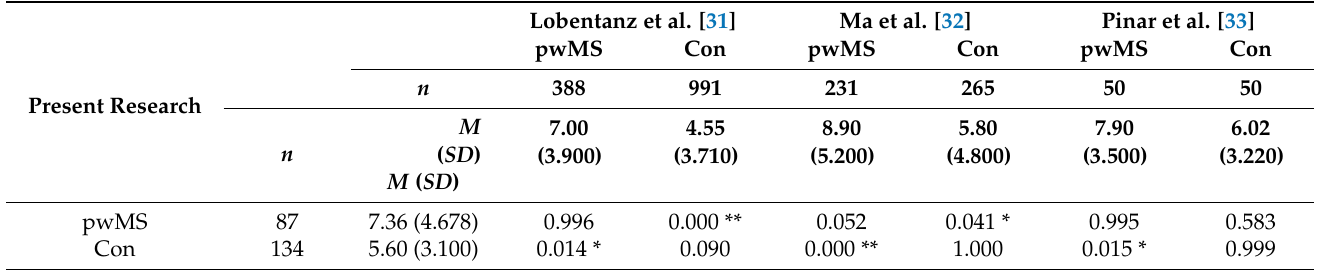
Table 7. Significance ( p ) of Tukey–Kramer HSD post hoc tests of differences between groups of patients with multiple sclerosis (pwMS) and control groups (Con) in the present and previous research and their means and standard deviations.